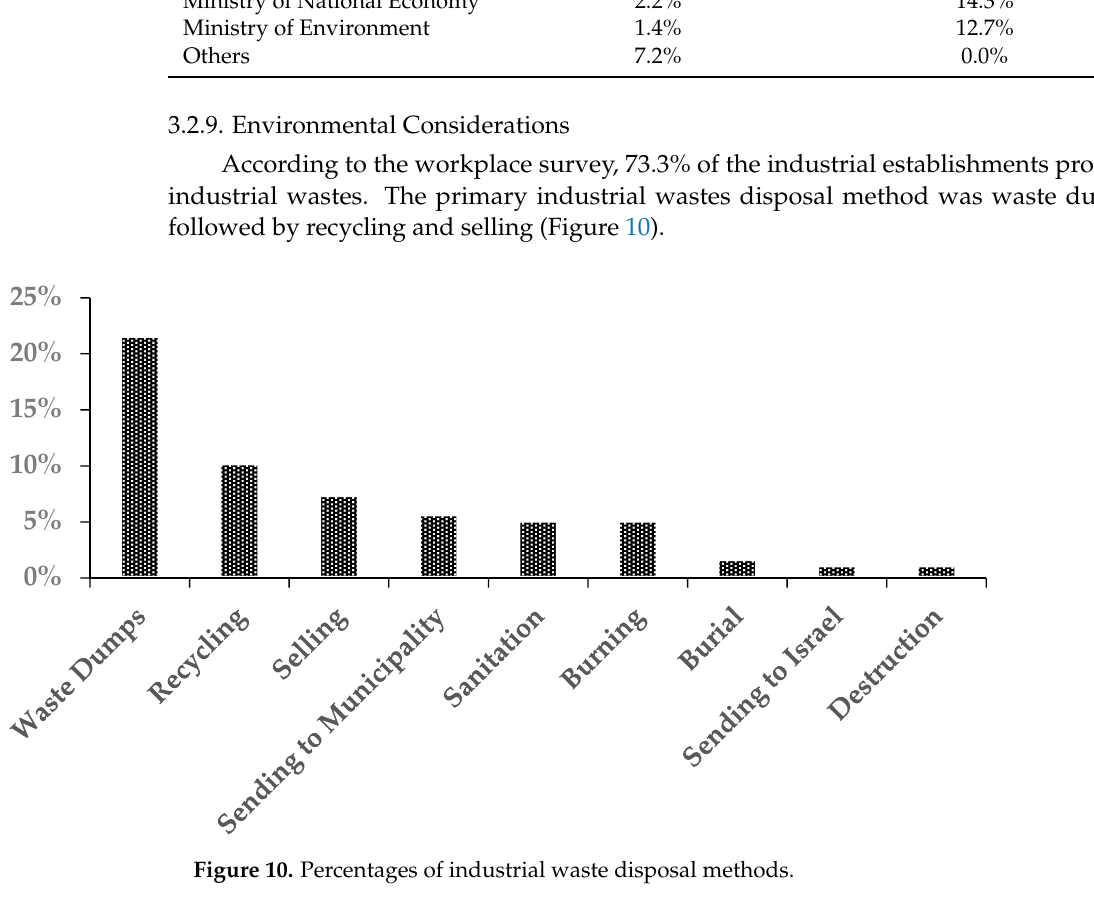
Figure 9. The percentages of the industrial establishments’ losses due to occupational accidents.